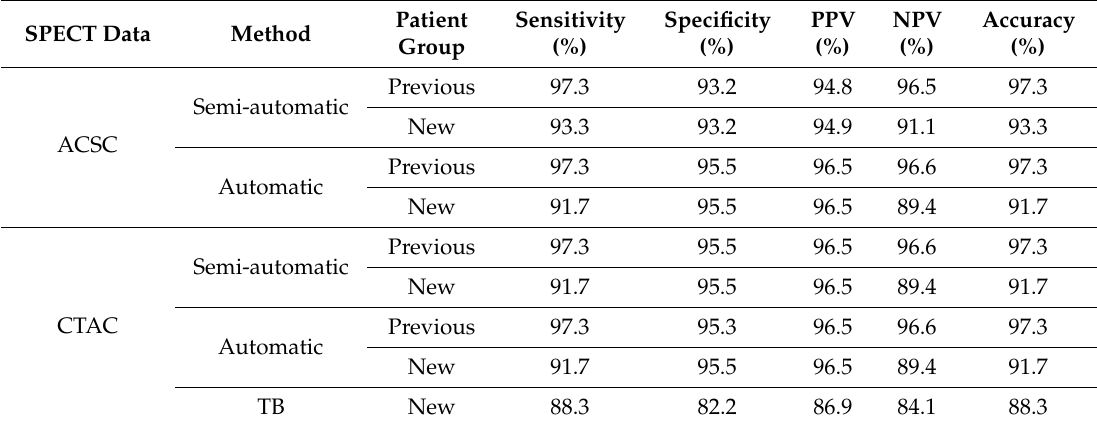
Figure 5. The parkinsonian syndrome (PS) group showed significantly greater SBR compared with the non-PS group (nPS) in the semi-and fully automatic methods for both ACSC ( a ) and CTAC ( b ) images ( p < 0.0001). The same cut-off values (ACSC = 2.15, CTAC = 1.88) differentiated the PS and non-PS groups with excellent diagnostic accuracy. The TB method with 4.5 cut-off ( c ) showed fair accuracy (see Table 1). Table 1. Sensitivity, specificity, positive predictive value (PPV), negative predictive value (NPV), and accuracy of semi-automatic and fully automatic methods.